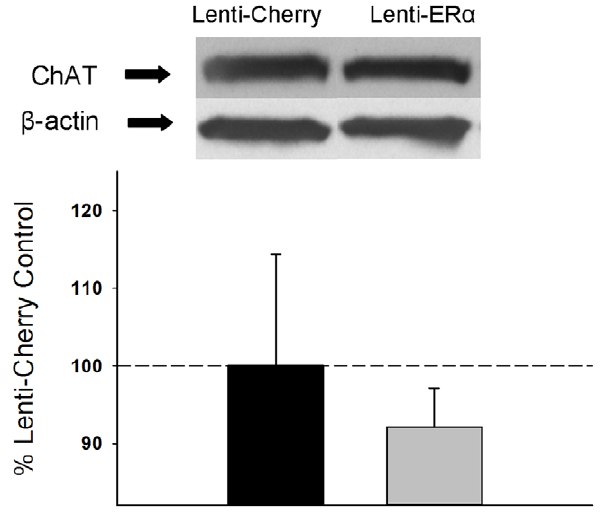
Figure 6. Effects of lenti-viral delivery to the hippocampus of the gene encoding ER a (Lenti-ER a ) or a control virus (Lenti- Cherry) to aging ovariectomized rats on protein expression of choline acetyltransferase (ChAT) in the hippocampus as measured by western blotting. Mean density x area ( + SEM) expressed relative to Lenti-Cherry control. Representative blot images for ChAT and the loading control b -actin are shown in insets above the